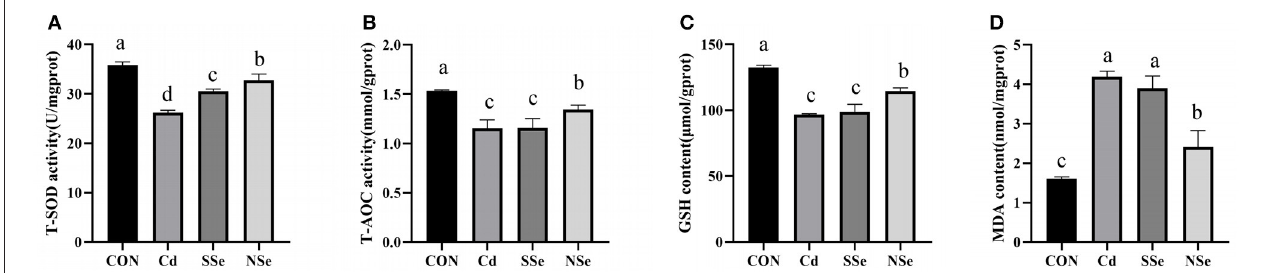
FIGURE 4 | Activities of antioxidant enzymes and concentrations of oxidative in liver. (A) T-SOD; (B) T-AOC; (C) GSH; (D) MDA. Different letters represent significant difference ( P < 0.05) within the column, and the same letters represent no significant difference ( P > 0.05).